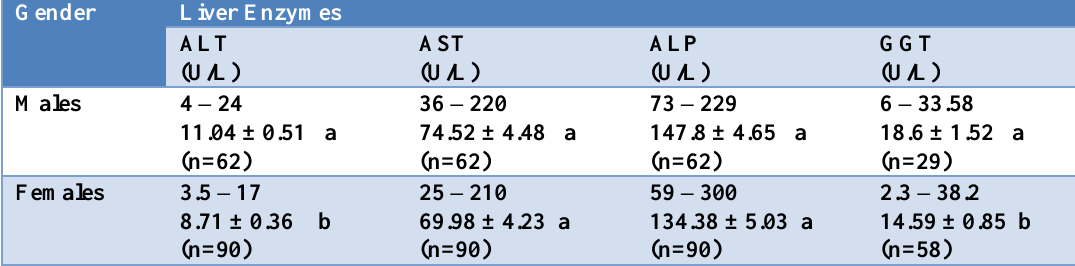
Table, 2: Serum values of ALT, AST, ALP and GGT activities according to sex in Awassi sheep (M±SE) Gender Liver Enzymes